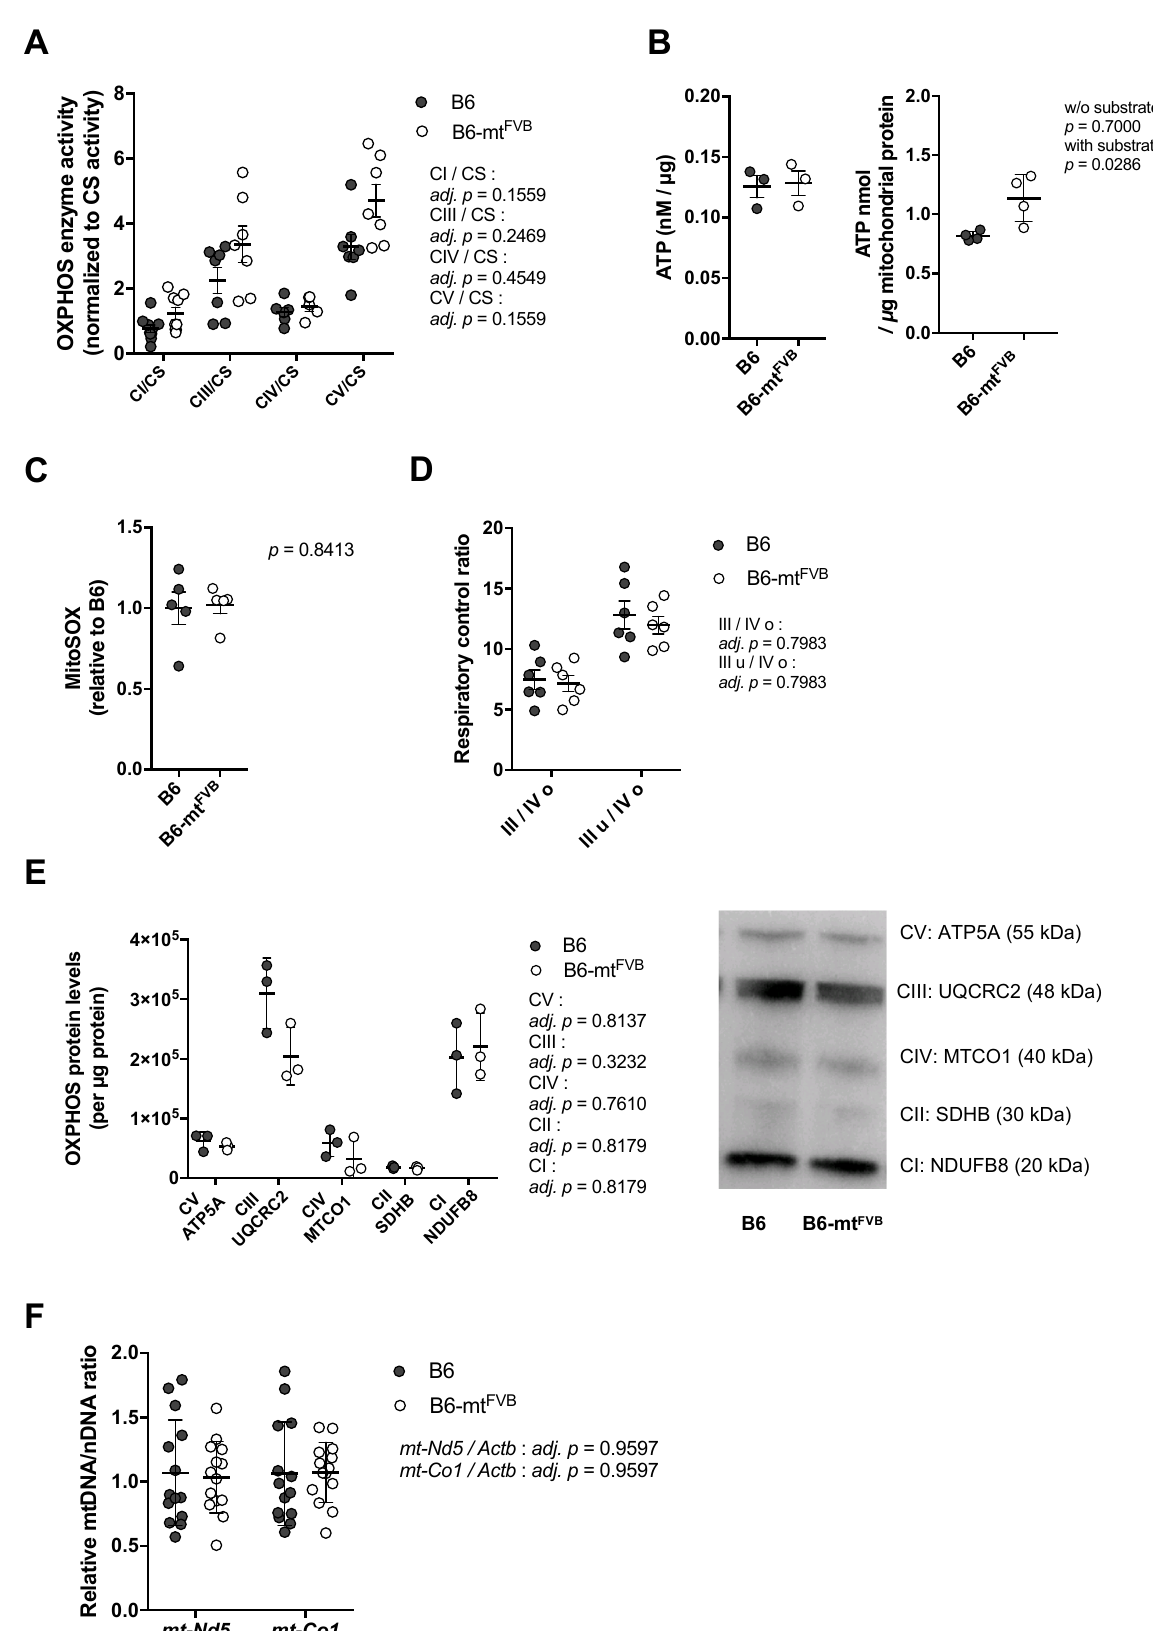
Figure 1. A natural polymorphism in the mitochondrially encoded ATP synthase 8 ( mt-Atp8 ) gene (m.7778G > T) has minor impact on mitochondrial oxidative phosphorylation (OXPHOS) function. ( A ) Levels of oxidative phosphorylation (OXPHOS) complex enzyme activities in liver mitochondria obtained from B6-mt FVB and B6 mice (age, sex) were